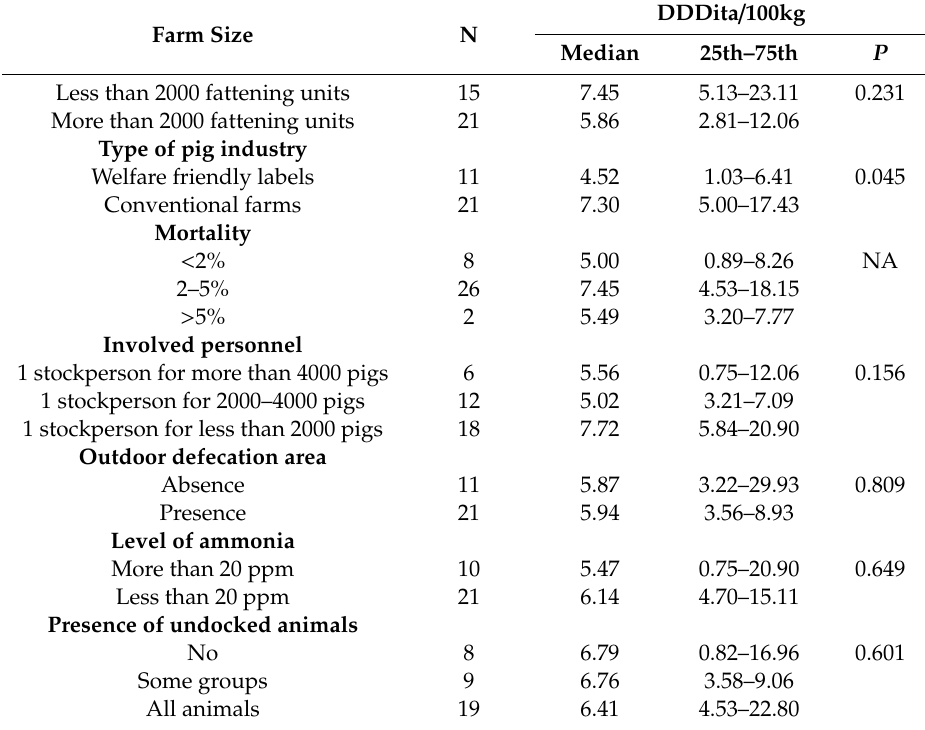
Table 2. Associations between defined daily doses per animal (DDDita / 100kg) and di ff erent variables in 2015–2017 (median value given with 25th–75th percentile) in 36 finishing farms in northern Italy.